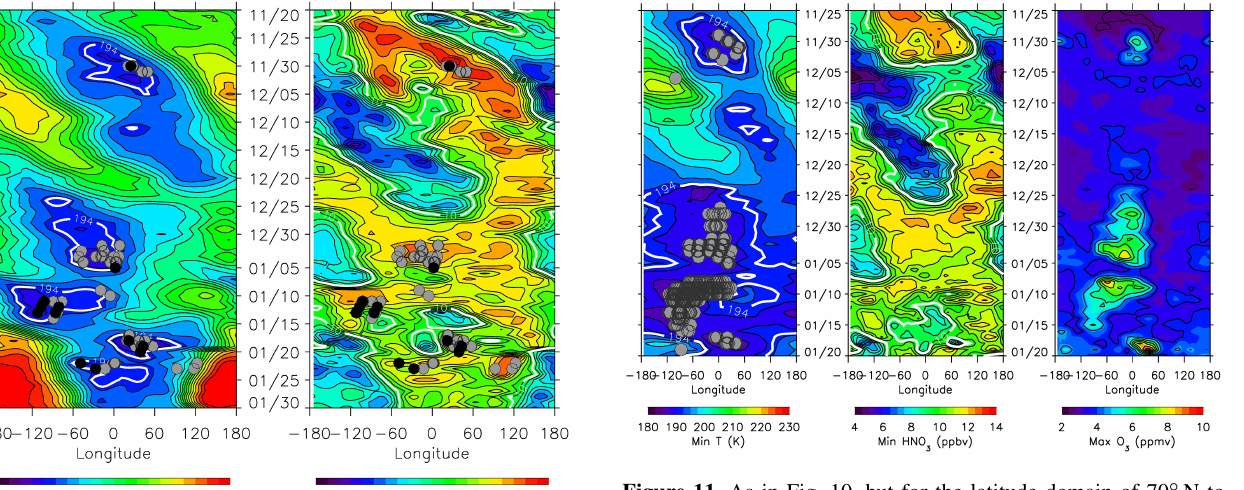
Figure 11. As in Fig. 10, but for the latitude domain of 70 ◦ N to the pole and from 25 November through 20 January; (left) fields of daily minimum temperature, (middle) daily minimum HNO 3 , and (right) daily maximum